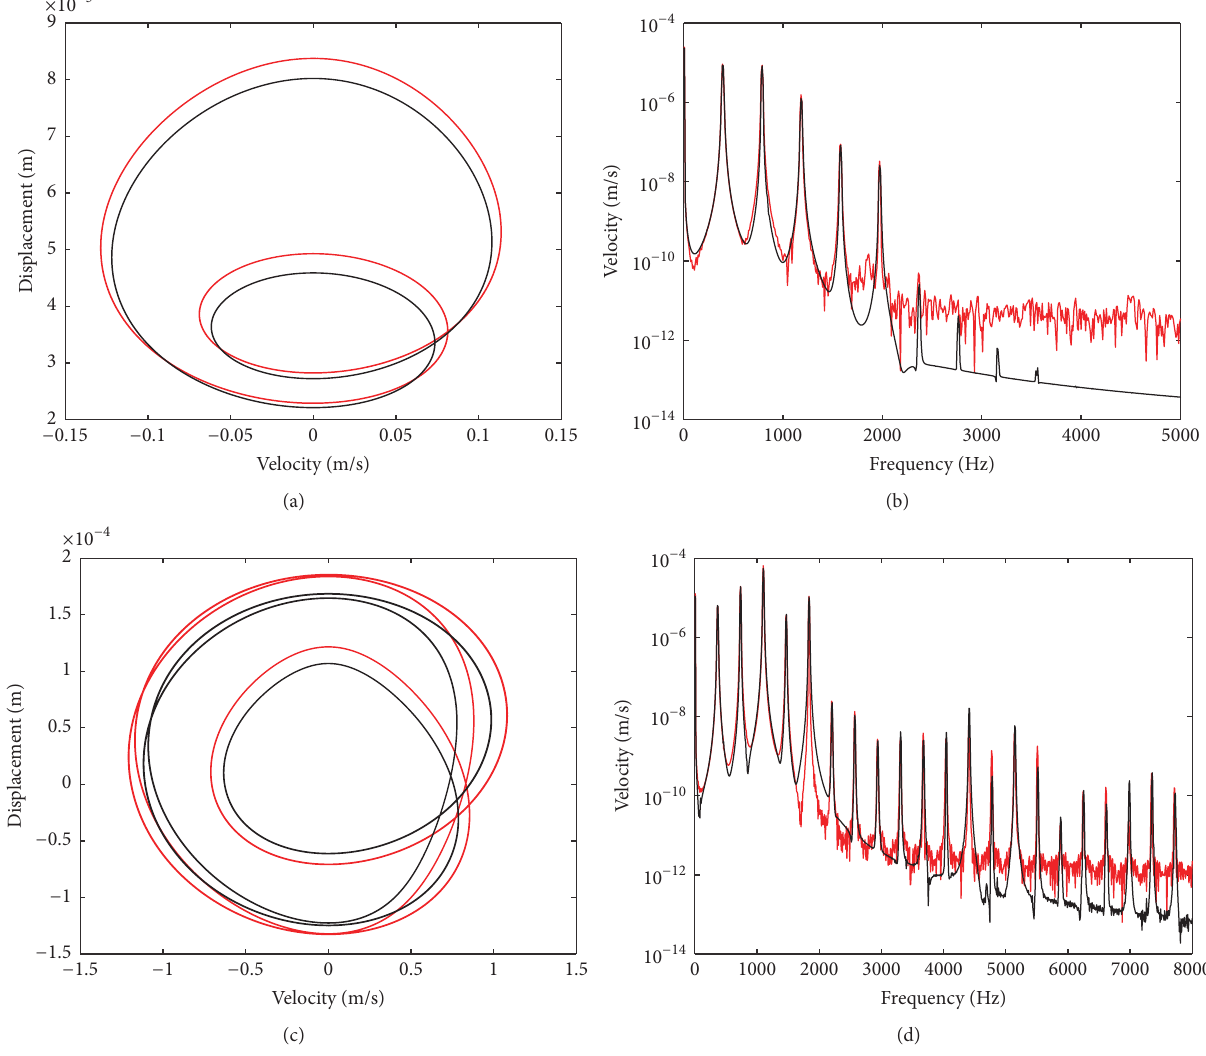
Figure 6: Limit cycles and Fast Fourier Transform on the stationary self-excited vibrations for one degree-of-freedom of the disc at the tangential component: (a, b) 𝜇 = 0.5 , (c, d) 𝜇 = 0.6 , (a, c) limit cycles, and (b, d) FFT, black color for the reference and red color for the reduced model with 15 interface